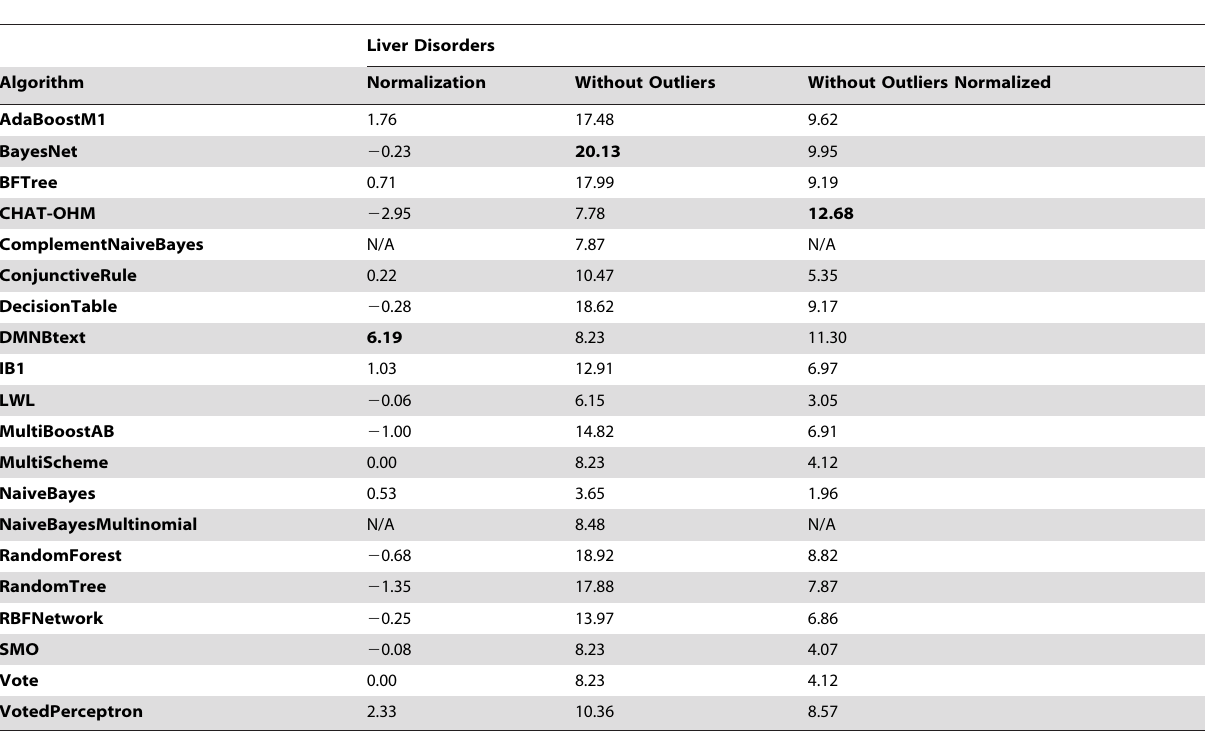
Table 11. Comparison of classification improvement (%) for liver disorders